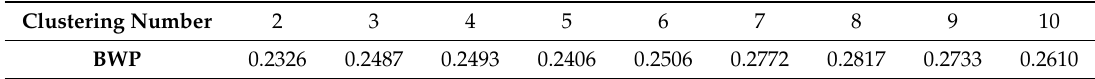
Table 2. BWP index of Z 1 with different number of clusters. Table 3. BWP index of Z 2 with di ff erent number of clusters.